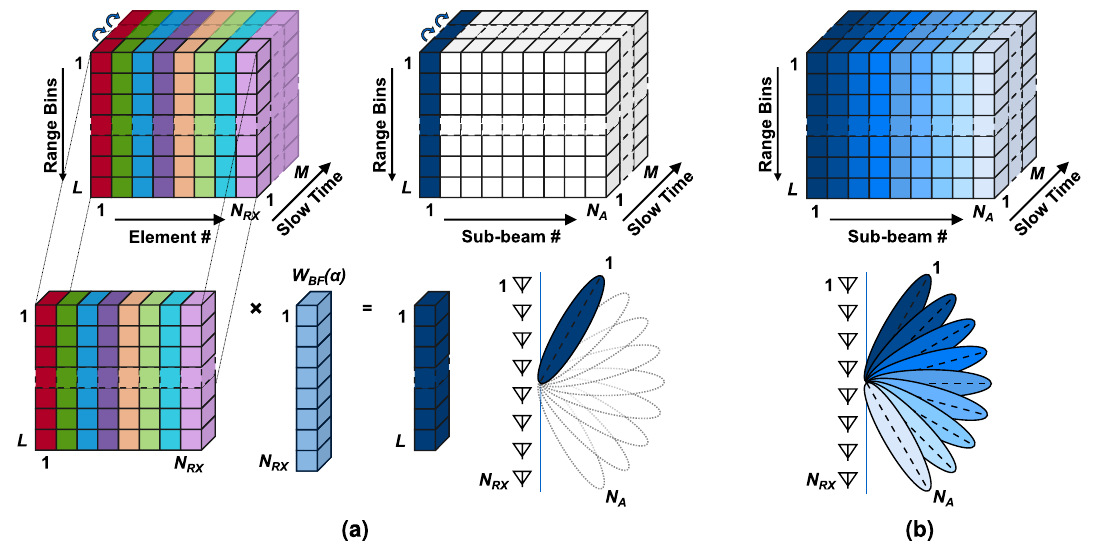
Figure 4. Graphical illustration of the rough beamforming algorithm. ( a ) Vector beamforming using the data cube and a weighting vector of a certain angle. ( b ) Angle data cube obtained after scanning all the angles under